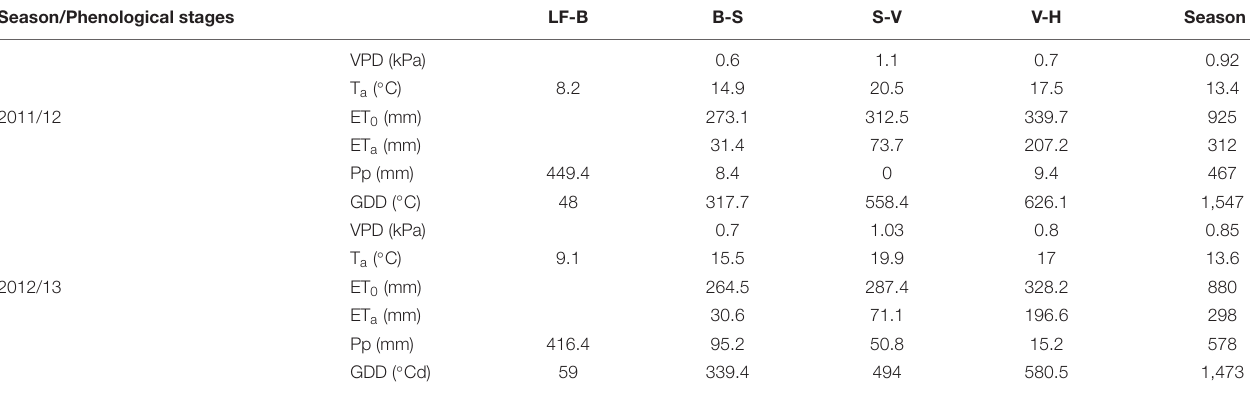
TABLE 2 | Mean values of climate variable and water requirements for the main phenological stages of a drip-irrigated Carménère vineyard. Season/Phenological stages